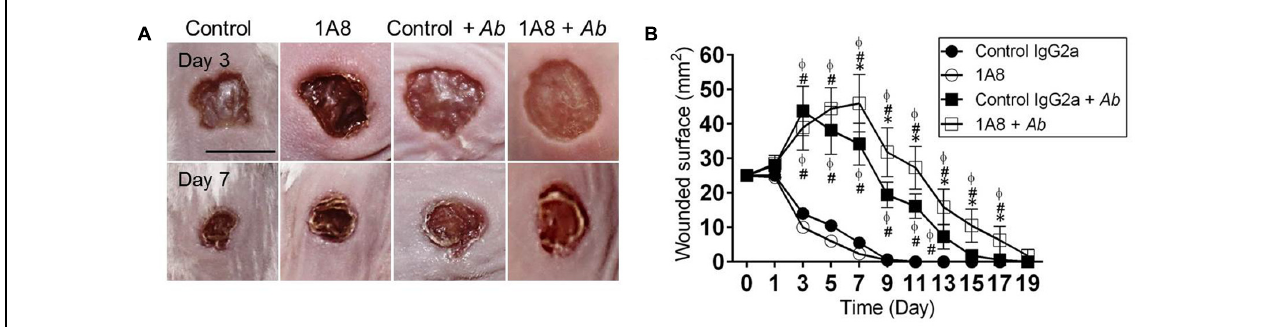
FIGURE 2 | Neutropenic mice with Acinetobacter baumannii ( Ab ) wound infection have reduced wound healing rate. (A) Wounds of Balb/c mice isotype-matching mAb-treated (control IgG2a), mAb 1A8-treated (1A8), control IgG2a-treated A. baumannii -infected (control IgG2a + A. baumannii ), and